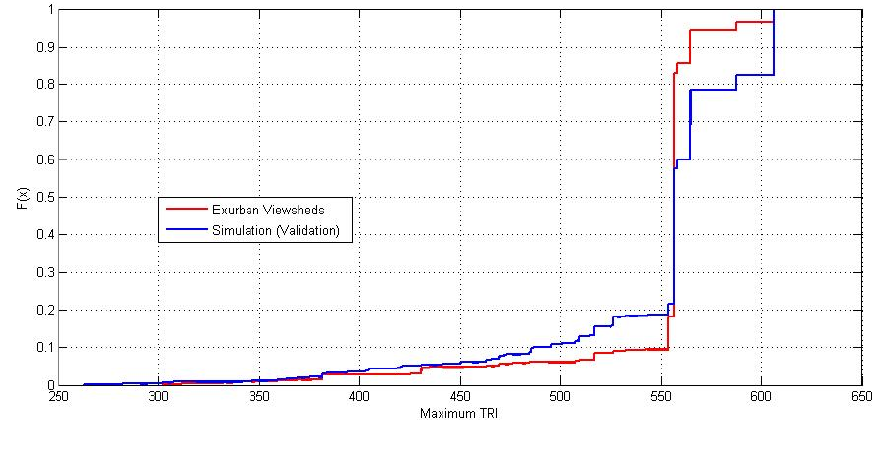
Figure 7. Cumulative distribution functions of maximum TRI values for actual exurban and simulated (validation)